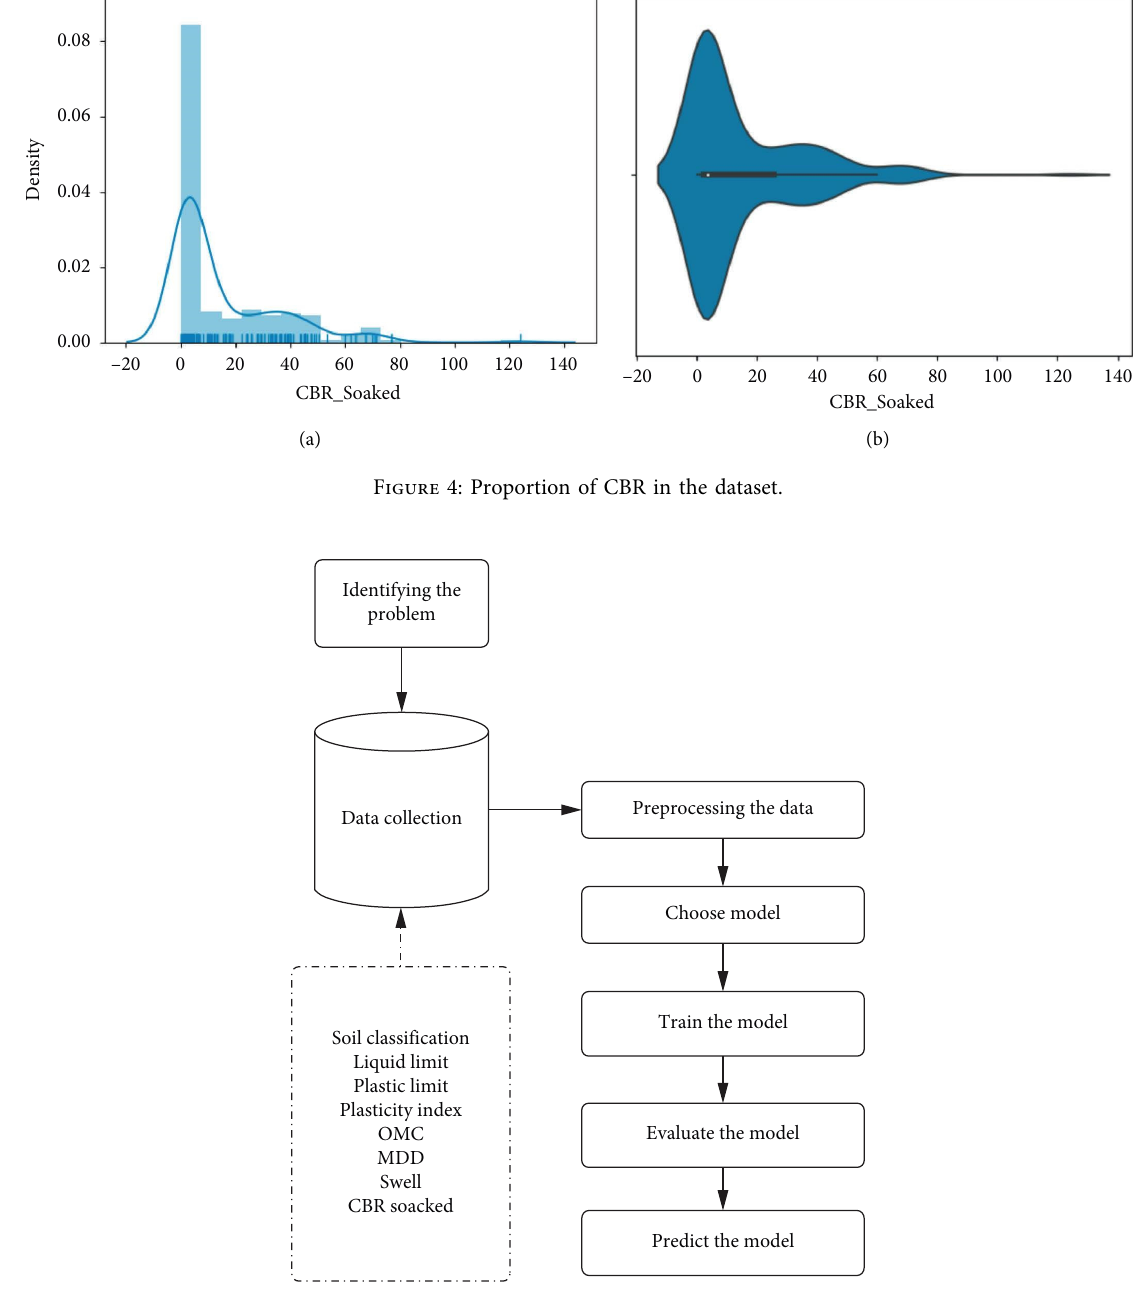
Figure 5: Flowchart of the